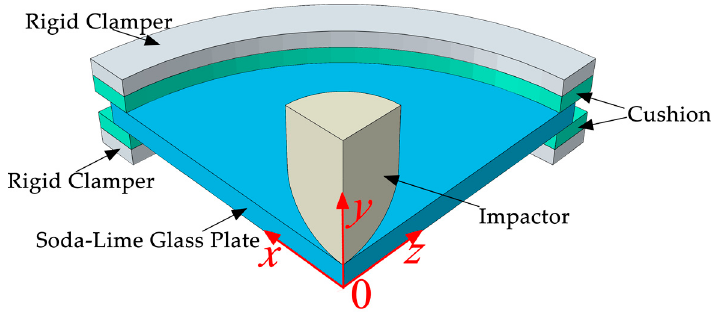
Figure 4. Schematic diagram of basic test device.